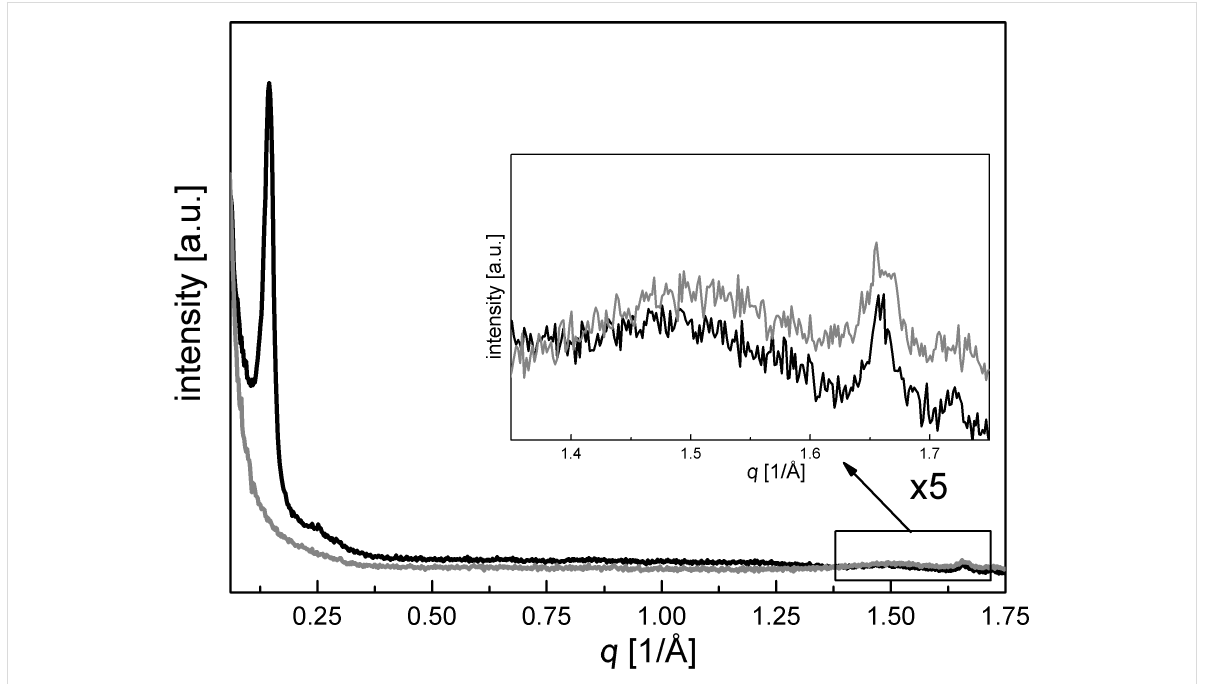
Figure 3: Neutron diffraction patterns of benzene-PMO at small and high q values for empty (black curves) and nitrogen-filled pores (gray curves).